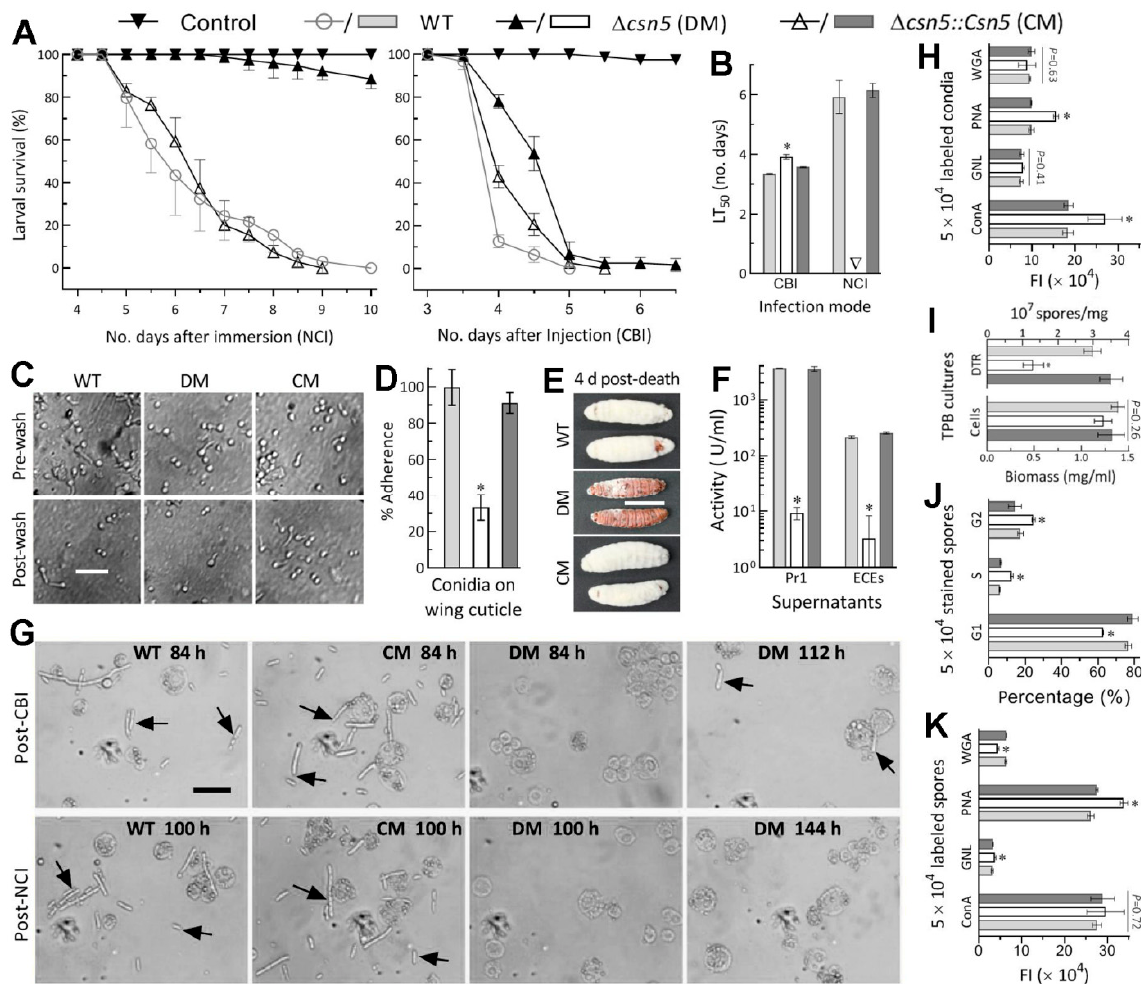
Figure 2. Essential role of Csn5 in the infection cycle and related cellular events of B. bassiana . ( A , B ) Time–survival trends of G. mellonella larvae after topical application (immersion) of a 10 7 conidia/mL suspension for normal cuticle infection (NCI) and intrahaemocoel injection of ~500 conidia per larva for cuticle-bypassing infection (CBI) and LT 50 s (number of days) estimated from the trends. ( C , D ) Microscopic images (scale bar: 20 μ m) for conidia attached to locust hind wings pre-wash and post-wash and conidial adherence assessed as percent ratios of pre-wash counts over post-wash counts with respect to the WT standard, respectively. ( E ) Images (scale bar: 10mm) of hyphal outgrowths on the surfaces of insect cadavers 4 days post-death via CBI. ( F ) Total activities of cuticle-degrading ECEs and Pr1 proteases quantified from the supernatants of 3-day-old CDB-BSA cultures, which were initiated by shaking 10 6 conidia/mL suspensions at 25 °C. ( G ) Microscopic images (scale bar: 20 μ m) for the presence and abundance of hyphal bodies (arrowed) and host haemocytes (spherical or subspherical cells) in haemolymph samples taken from surviving larvae post-NCI or post-CBI. Note that the ∆ csn5 mutant failed to produce hyphal bodies 144 h post-NCI and produced very few 110 h post-CBI. ( H ) Carbohydrate epitope patterns of conidia labelled with four fluorescence lectins. ( I ) Biomass levels and dimorphic transition rates measured from 3-day-old TBP cultures mimicking insect haemolymphs. ( J , K ) Distribution of DNA profiles for the cell cycle phases of DNA-stained blastospores in the TPB cultures and carbohydrate epitope patterns of those blastospores labelled with four fluorescence lectins, respectively. * p < 0.05 ( B ), * p < 0.01 ( H , J , K ), or * p < 0.001 ( D , F , I ). Error bars: SDs of the means from three independent replicates.